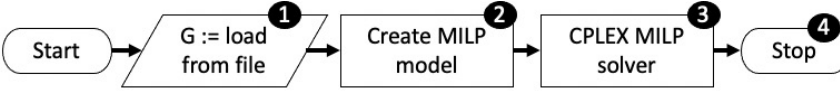
Figure 4. Algorithm